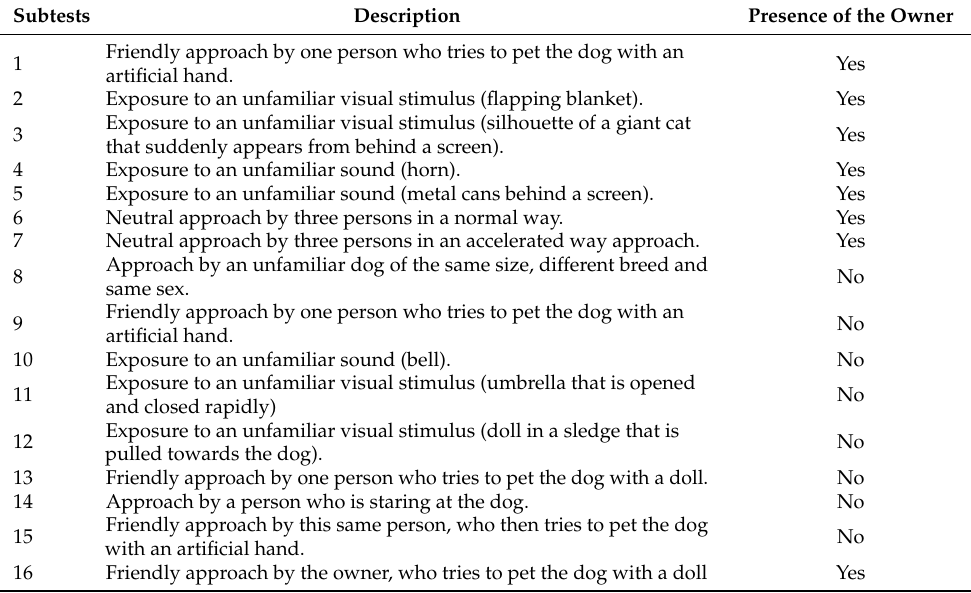
Table A2. The main characteristics and order of the 16 spelled-out subtests in the Socially Acceptable Behaviour